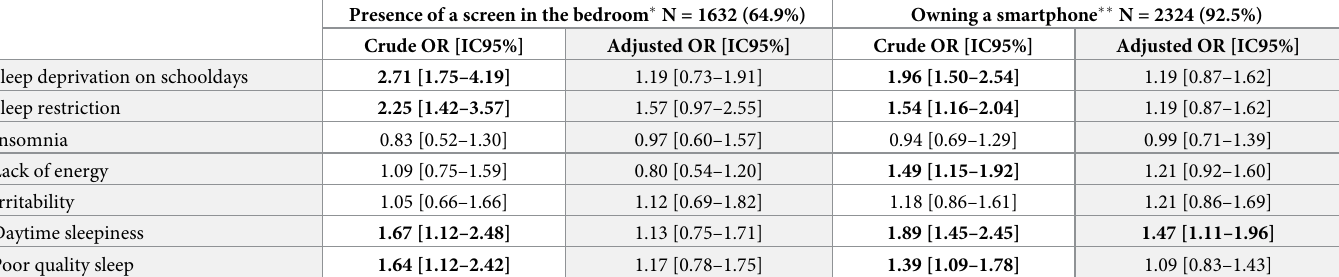
Table 3. The association between the presence of screens in the bedroom or owning a smartphone on sleep and daytime function adjusted for age, sex and sociode- mographic class. Presence of a screen in the bedroom � N = 1632 (64.9%)